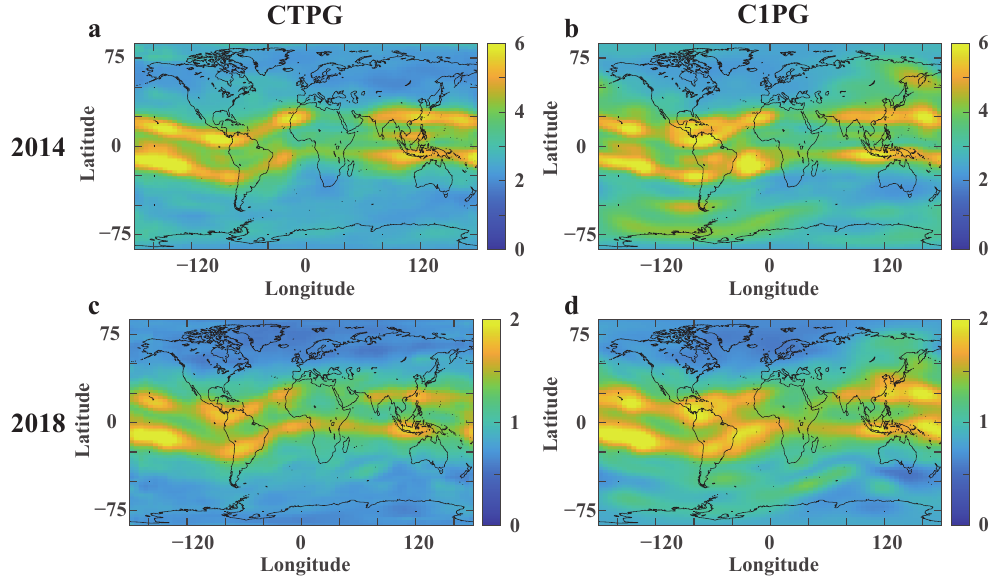
Figure 8. MAE values between predicted TEC maps (CTPG and C1PG) and the IGS TEC maps (CODG) in 2014 and 2018. ( a ) MAE of CTPG in 2014. ( b ) MAE of C1PG in 2014. ( c ) MAE of CTPG in 2018. ( d ) MAE of C1PG in